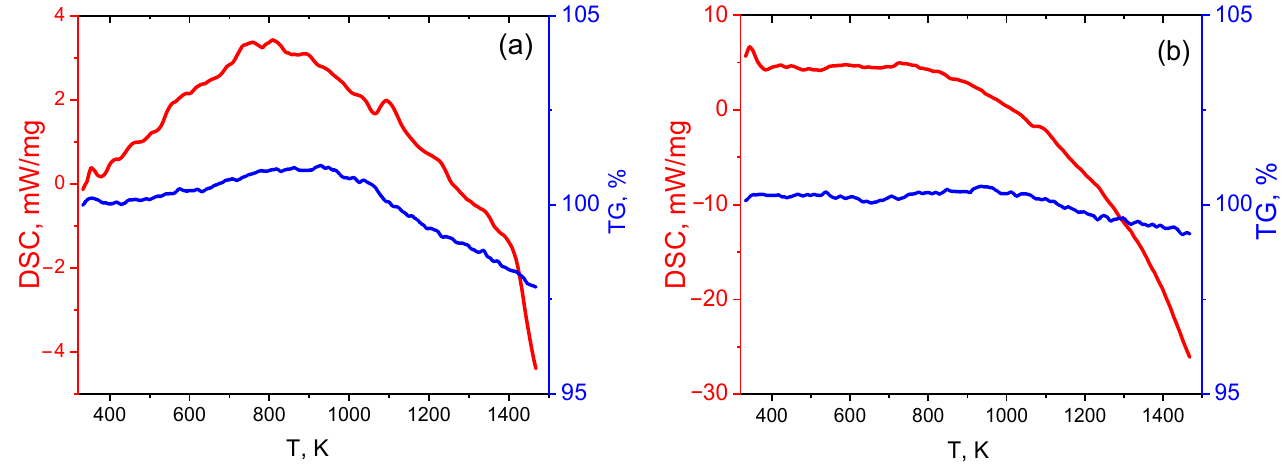
Figure 4. DSC (red) and TGA (blue) curves for samples S1 ( a ) and S2 ( b ).